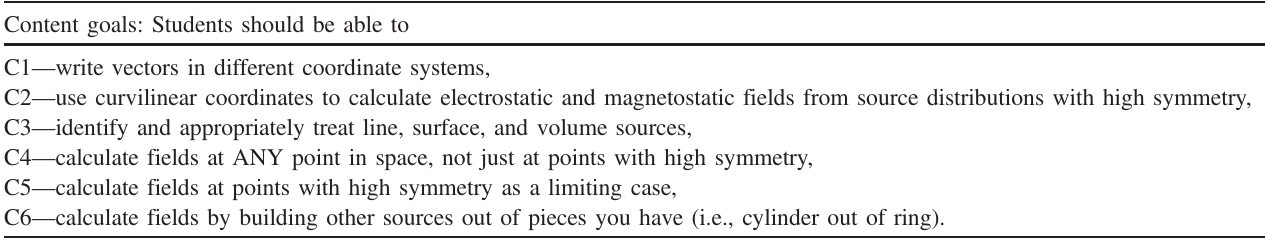
TABLE I. The learning goals associated with the ring cycle. Content goals: Students should be able to